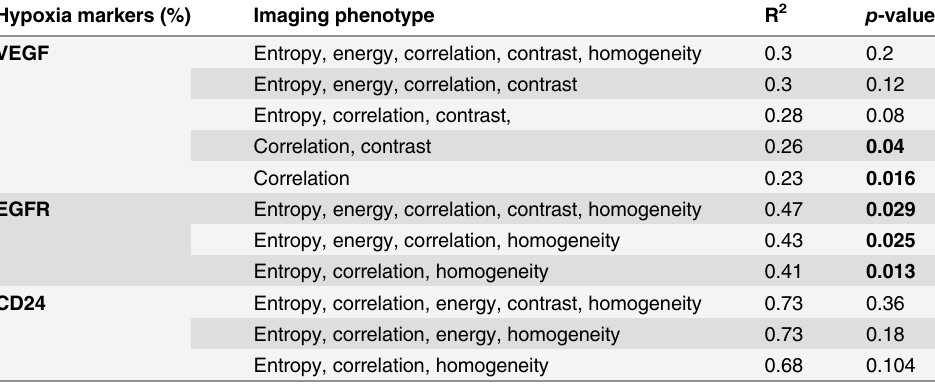
Table 1. Multiple linear regression analysis of hypoxia markers and quantitative imaging